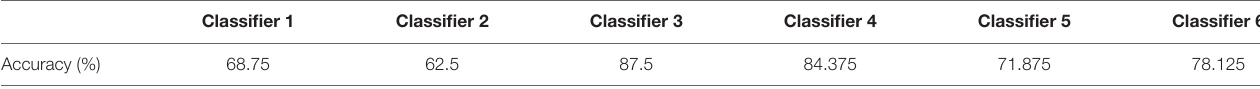
TABLE 2 | Accuracy of the six long short-term memory classifiers to the samples in training group 2.